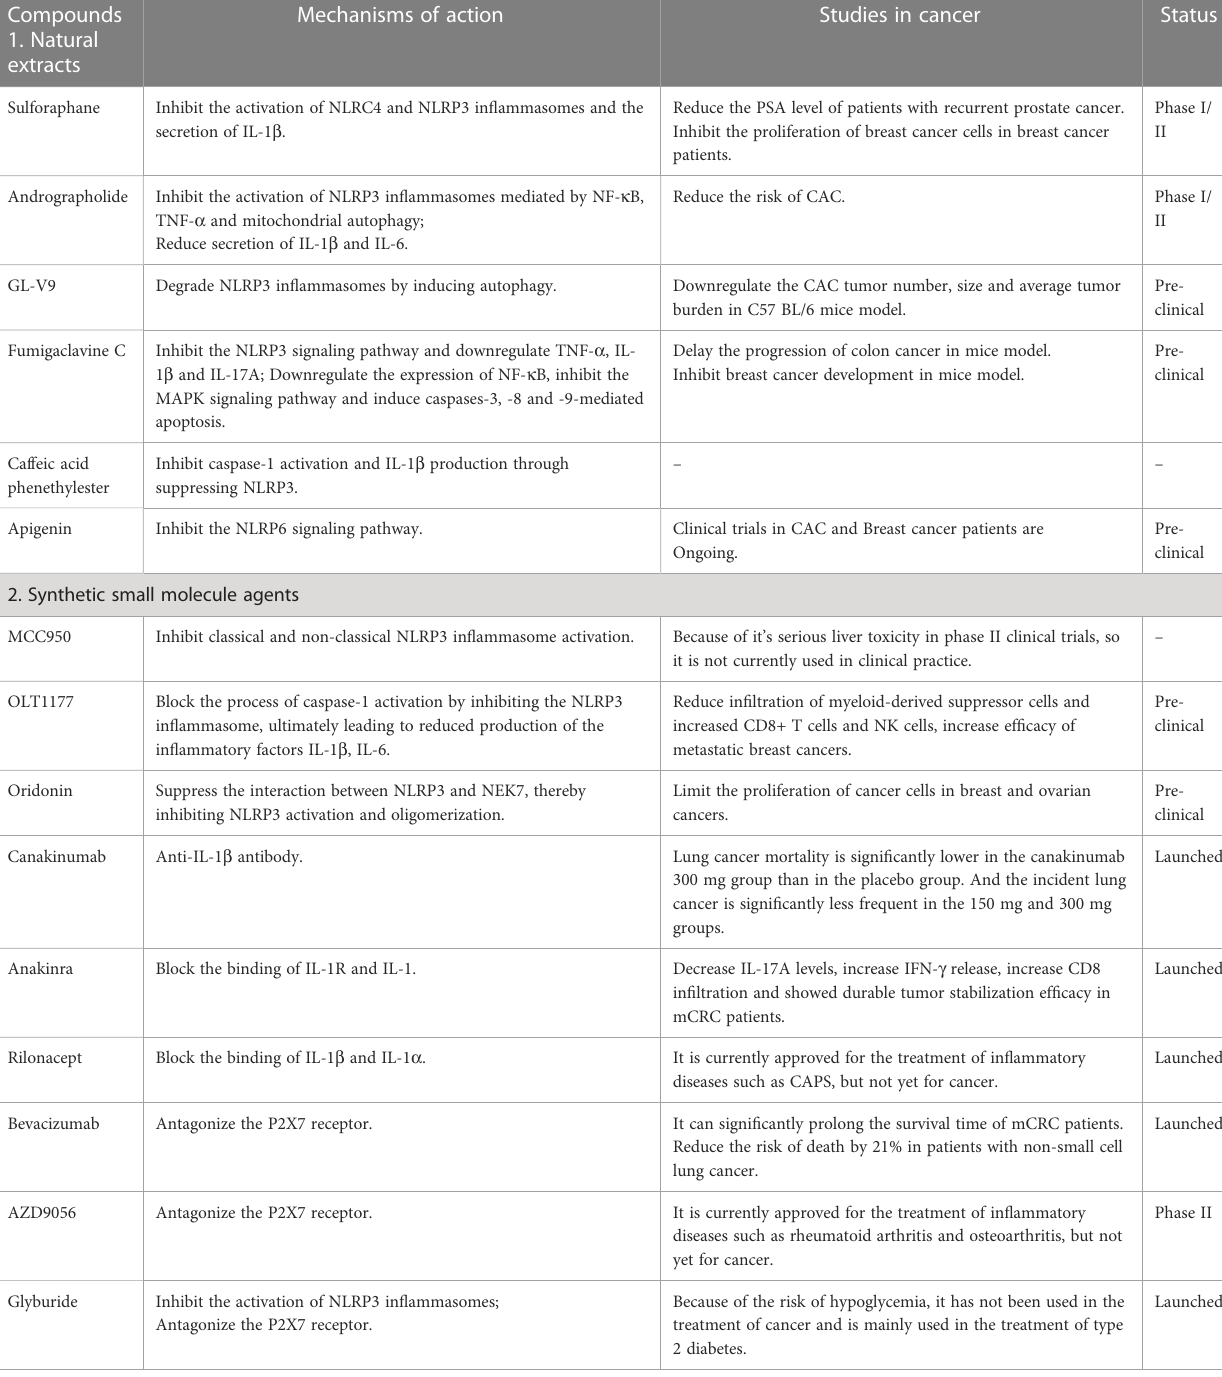
TABLE 2 The agents targeting in fl ammasomes for cancer treatment. Compounds Mechanisms of action Studies in 1. Natural extracts